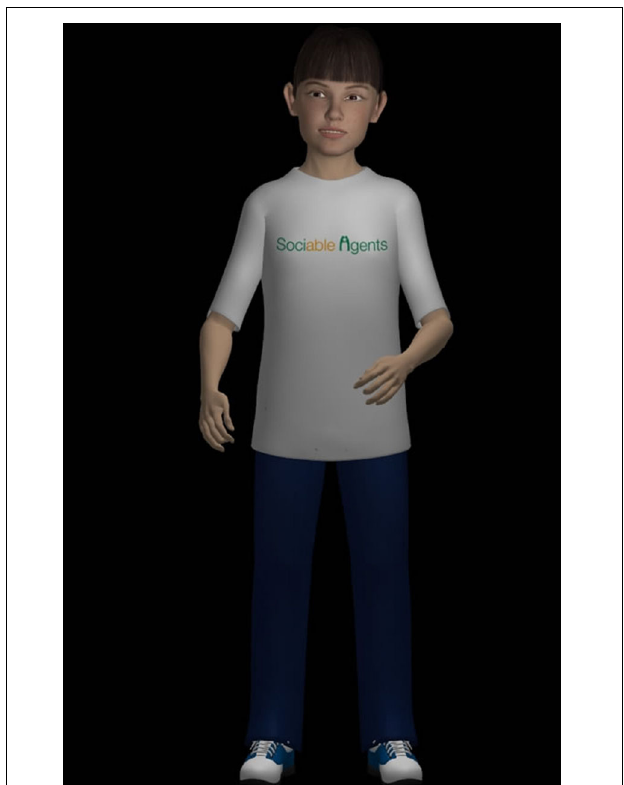
FIGURE 1 | Screenshot of the virtual agent